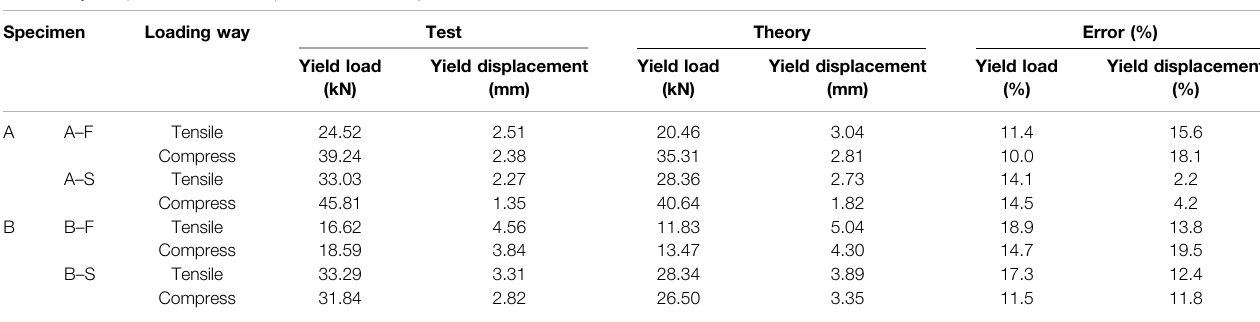
TABLE 3 | Comparison between experiment and